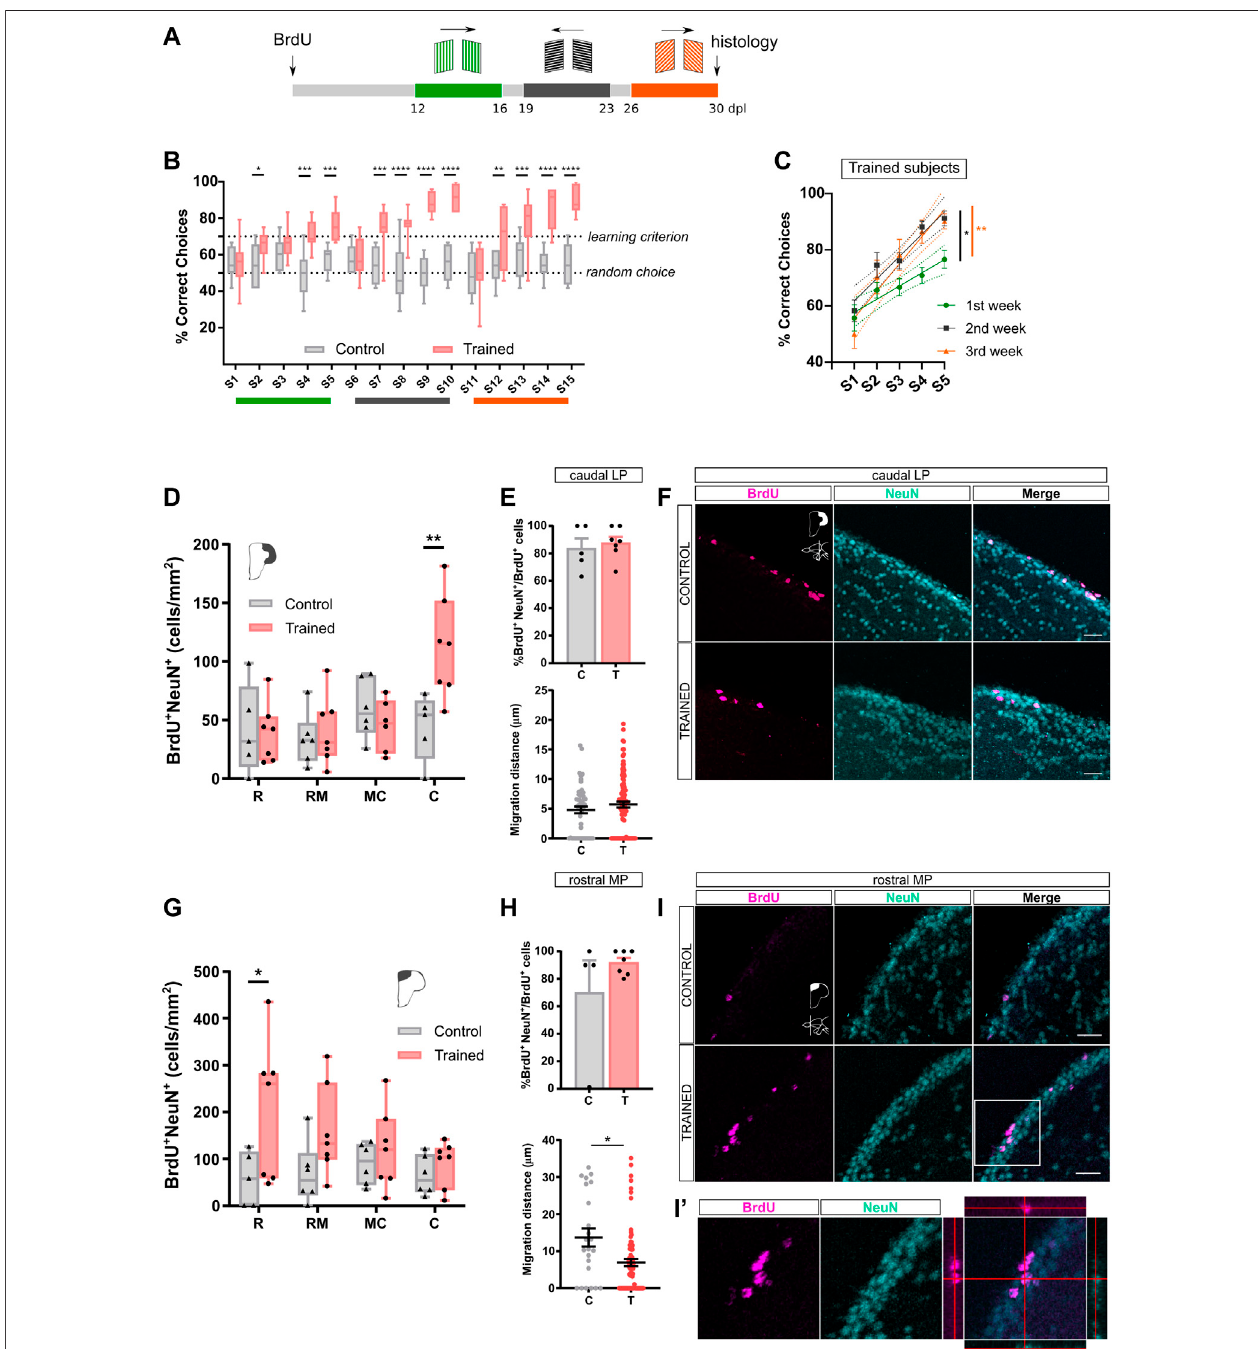
FIGURE2 | Sustained training of zebra fi sh from 12 – 30dpl increases adult neurogenesis exclusively inthe cLP and the rMP. (A) . Experimental schedule. Fish were immersed in BrdU, and training started at 12 dpl. Training consisted of 15 sessions, distributed in three slots. Every fi ve sessions both cues and exit position were changed. A 2-day interval was fi xed between slots. At 30 dpl fi sh were euthanised for histology. (B) . Learning curves for Trained and Control individuals (Two-way RM ANOVA, Treatment effect: F (1, 14) = 67.71 with p < 0.0001, Session effect: F (14, 196) = 6.805 with p < 0.0001. Bonferroni ’ s multiple comparisons test, * depicts p < 0.05, ** p < 0.01, **** p < 0.0001. Trained, N = 8; Control N = 8). (C) . Simple linear regression for each training windowfor Trained fi sh (ANCOVA, fi rst vs. 2nd week: F (1,76) = 4.647; 1st vs. 3rd week: F (1,76) = 7.068, * indicates p < 0.05, **, p < 0.01. Trained, N = 8; Control N = 8). (D). BrdU + NeuN + cell quanti fi cation in LP (Two-way ANOVA, Treatment effect: F (1, 41) = 2.766 with p = 0.103, Pallium region effect: F (3, 41) = 4.493 with p = 0.0098. Bonferroni ’ s multiple comparisons test, ** p < 0.01. Trained, N = 7; ControlN=6). (E) .Top:Neuronalfate(%BrdU + NeuN + /BrdU + cells)incaudalLP(Unpaired t test,t (10) =0.5091,n.s.Trained,N=7;ControlN=5).Bottom:Cellmigrationin caudal LP (Mann Whitney test, U = 2419, n. s. Trained, N = 7; Control N = 6). (F) . Adult-born neurons (BrdU/NeuN) in cLP for Trained and Control individuals. Scale bar,